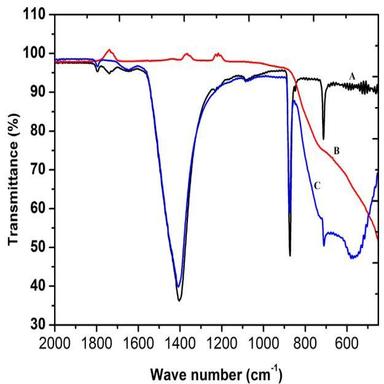
FTIR spectra showing (A) eggshell powder; (B) TiO2-EB (C) titanium dioxide.